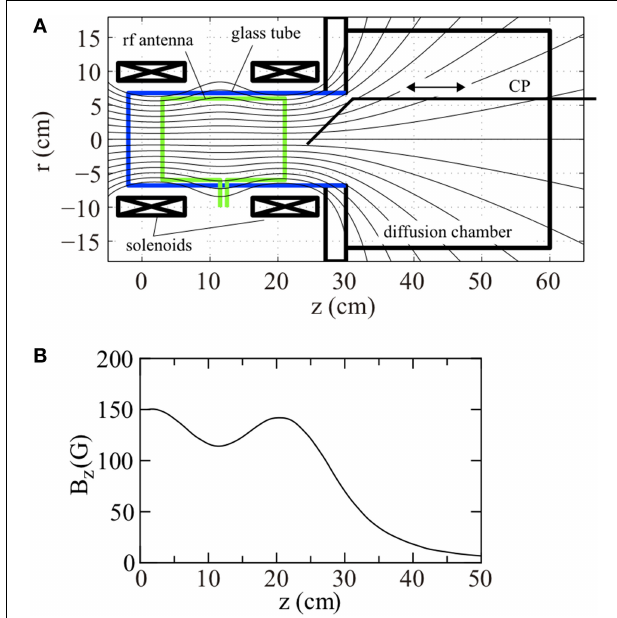
FIGURE 1 | (A) Schematic of the “Chi Kung” expanding magnetic field plasma experiment showing main components (CP is the rf compensated Langmuir Probe) and (B) B z component of magnetic field along the main axis.